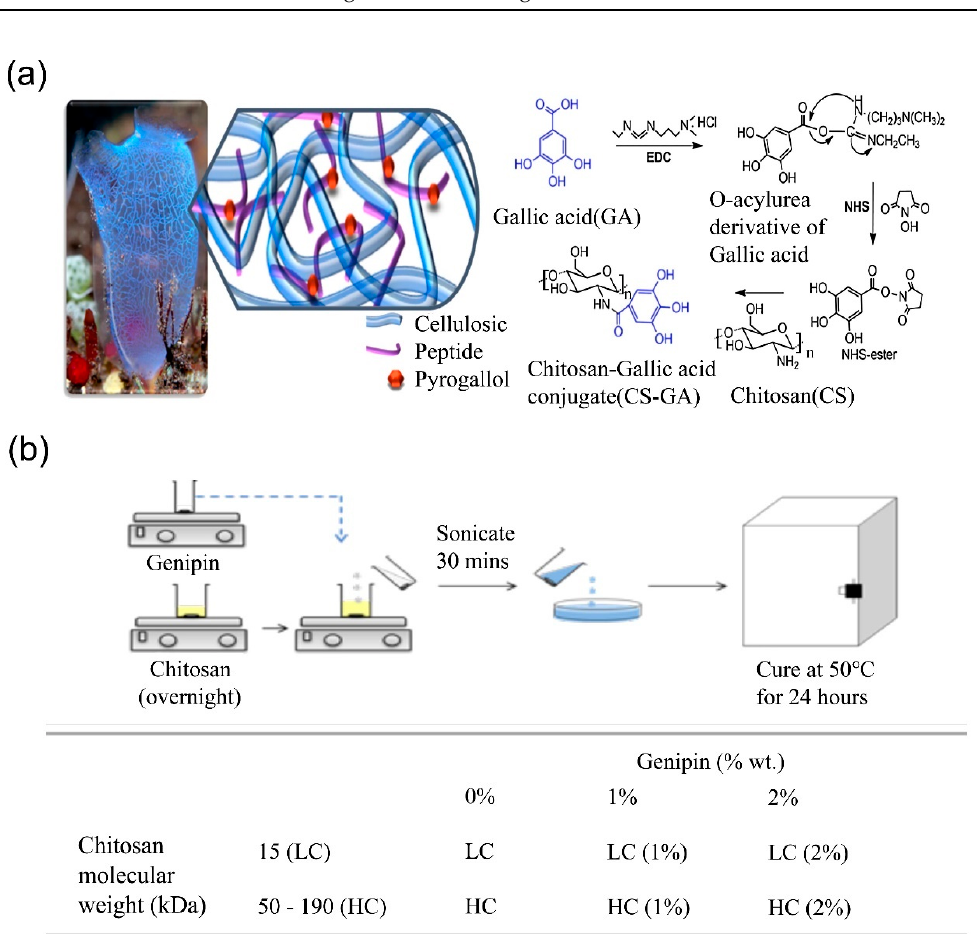
Figure 5. ( a ) Schematic diagram of the structure of tunicate and synthesis process of CS-GA [106].